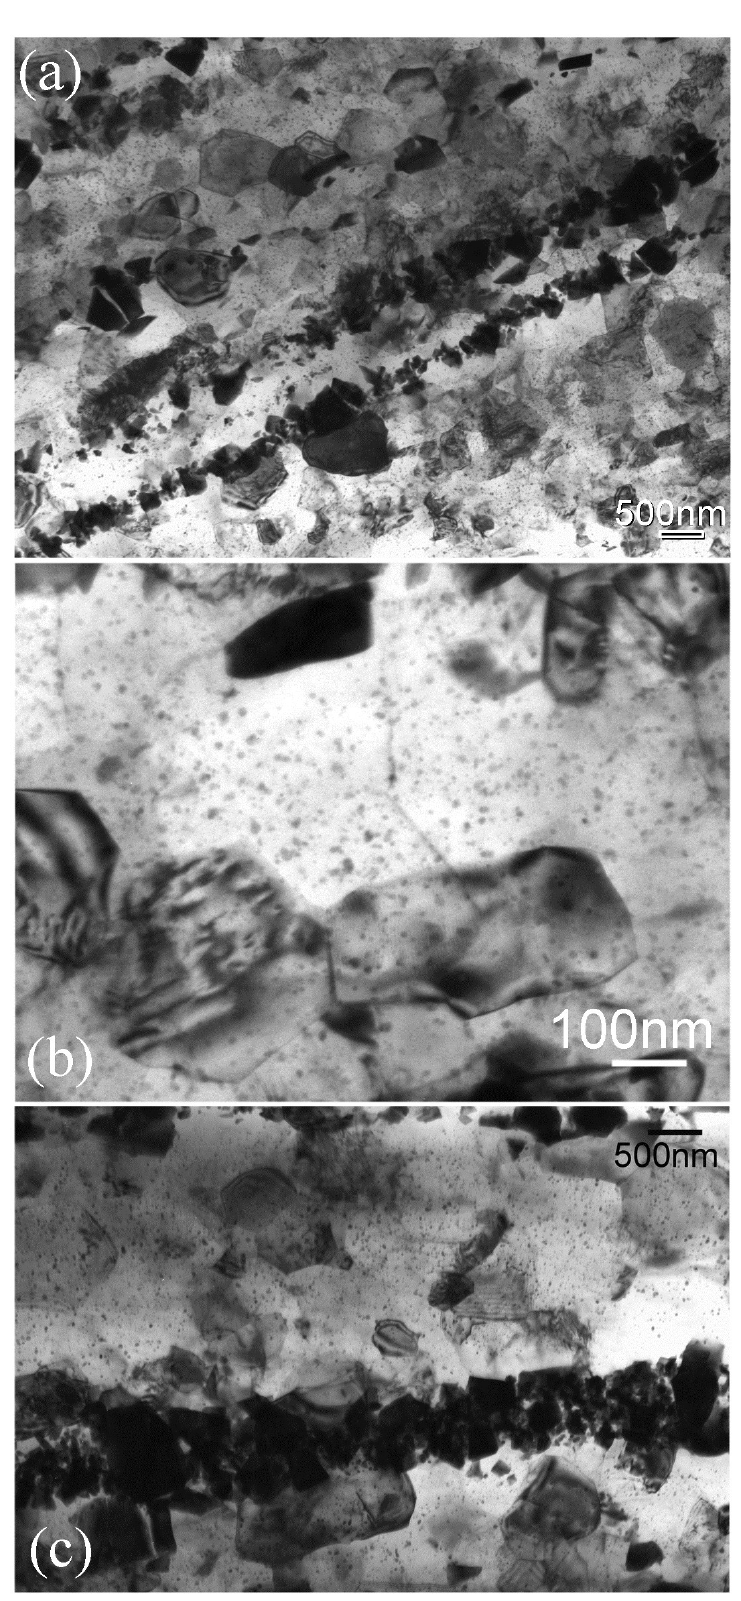
Figure 11. TEM micrographs showing microstructure of the ( a , b ) conventionally cast and ( c ) water-cooled cast alloy after extrusion. Dark phase is the i -phase. Very fine precipitate (as seen in ( b )) are observed in all extruded